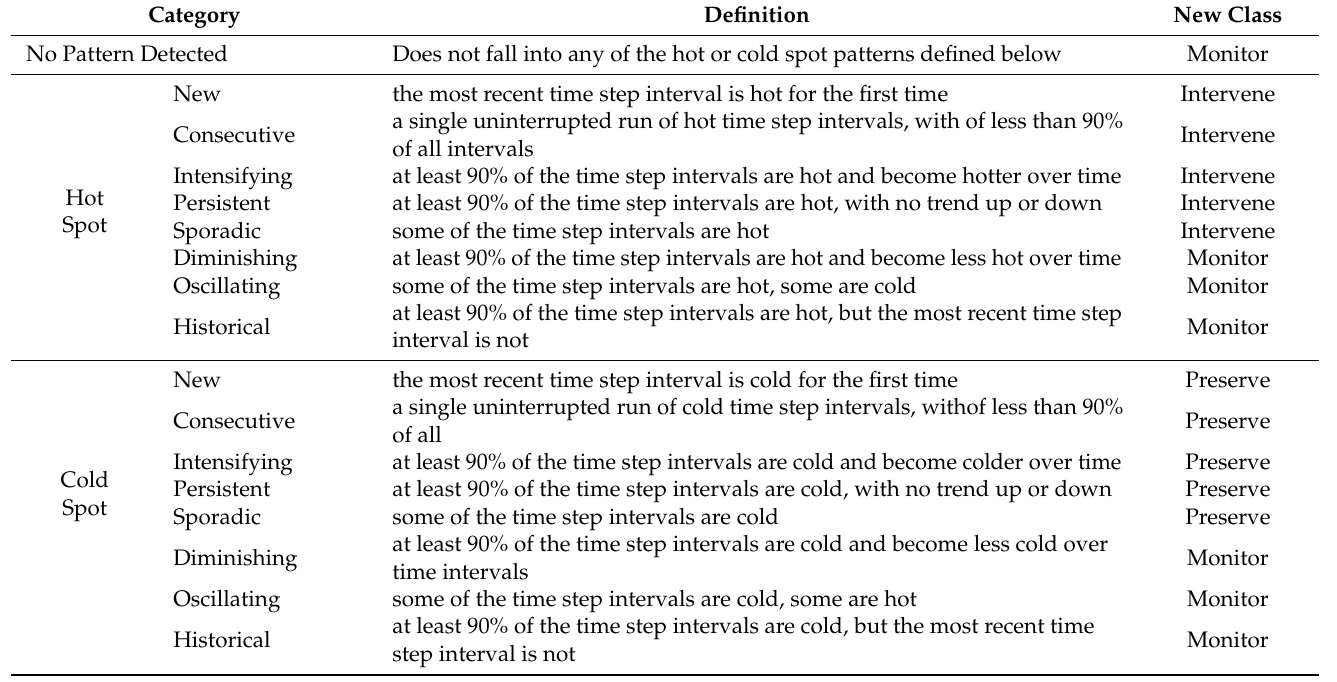
Table 7. Emerging hot spot analysis trend categories, their definition, and equivalent new